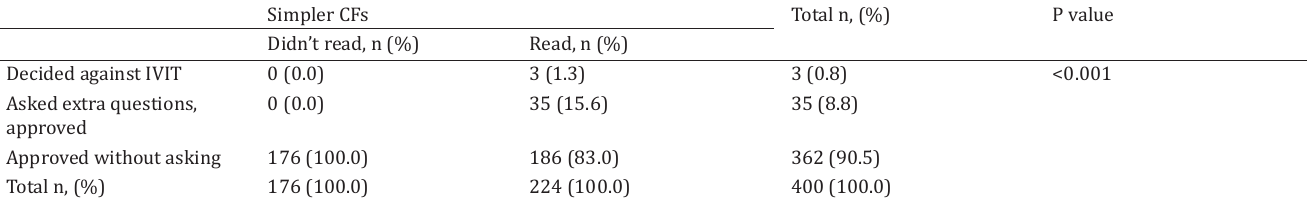
Comparative analysis the patients' pre-IVIT preferences based on simpler CFs